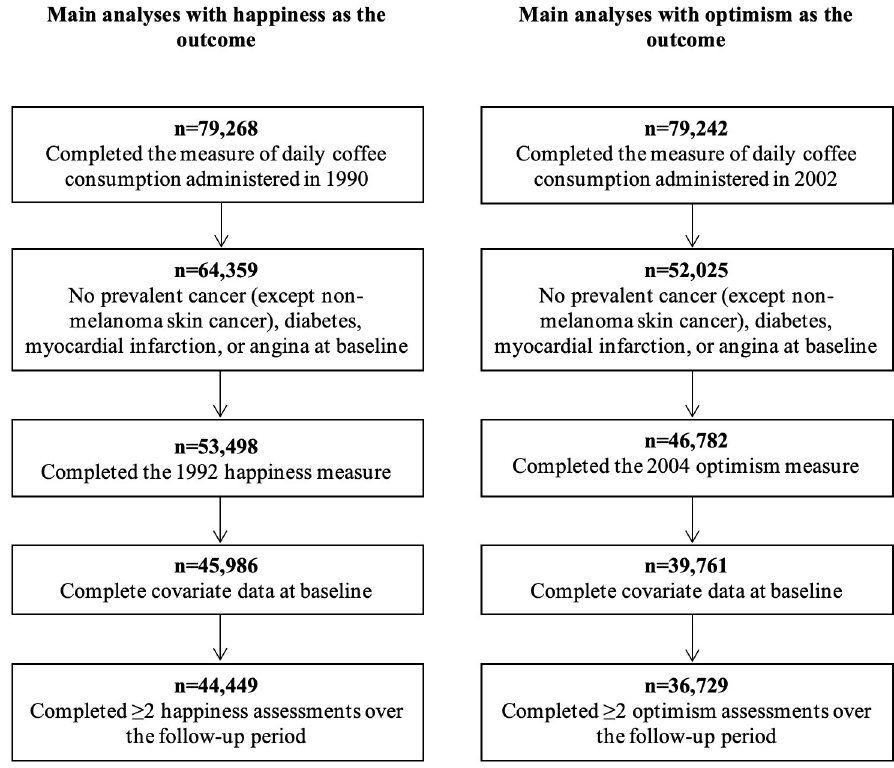
Fig 1. Flowchart of Nurses’ Health Study participants included in the final analytic